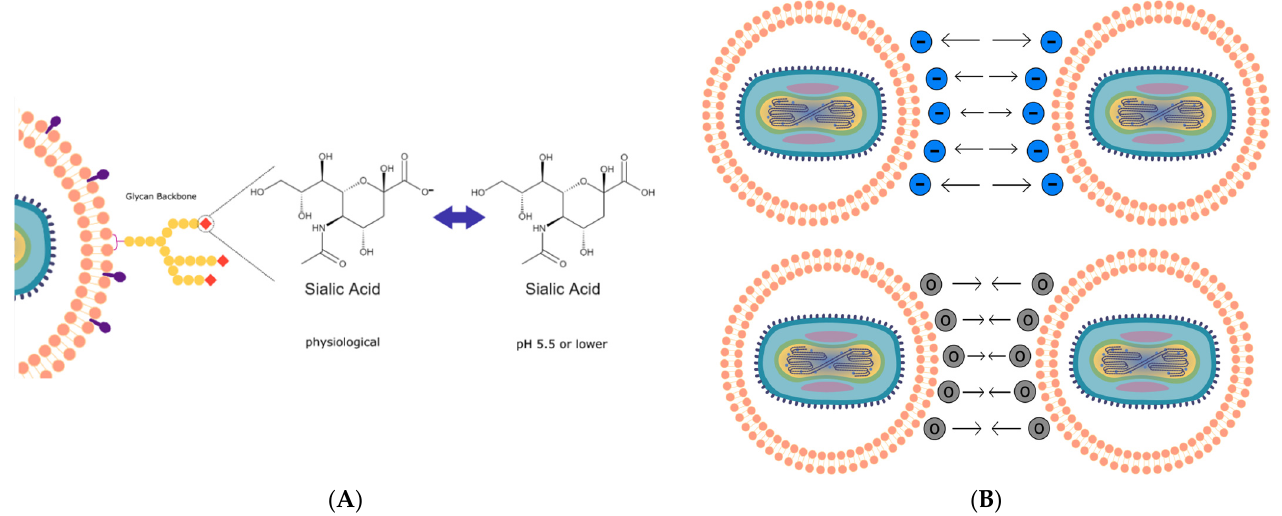
Figure 3. ( A ) Schematic of the basis of our model: protonation of sialic acid residues at any pH lower than the physiological pH neutralizes the strongly negative charges. ( B ) Diagram showing lowering the electrostatic repulsion between the particles via charge neutralization. DLVO theory predicts a threshold where the attractive Van der Waals forces will bring particles together in aggregation.